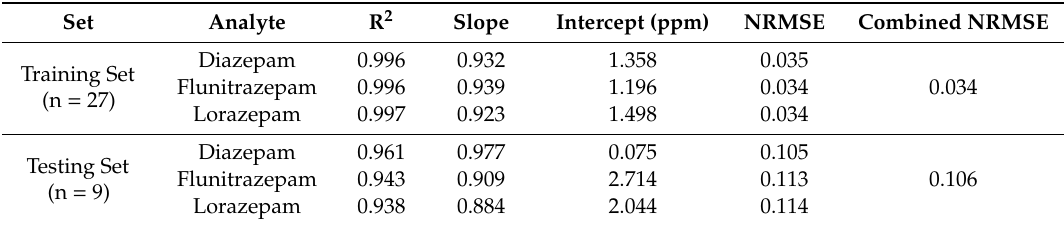
Table 1. Results of the fitted regression lines for obtained vs. expected values for the training and testing subsets of samples and the three considered compounds.